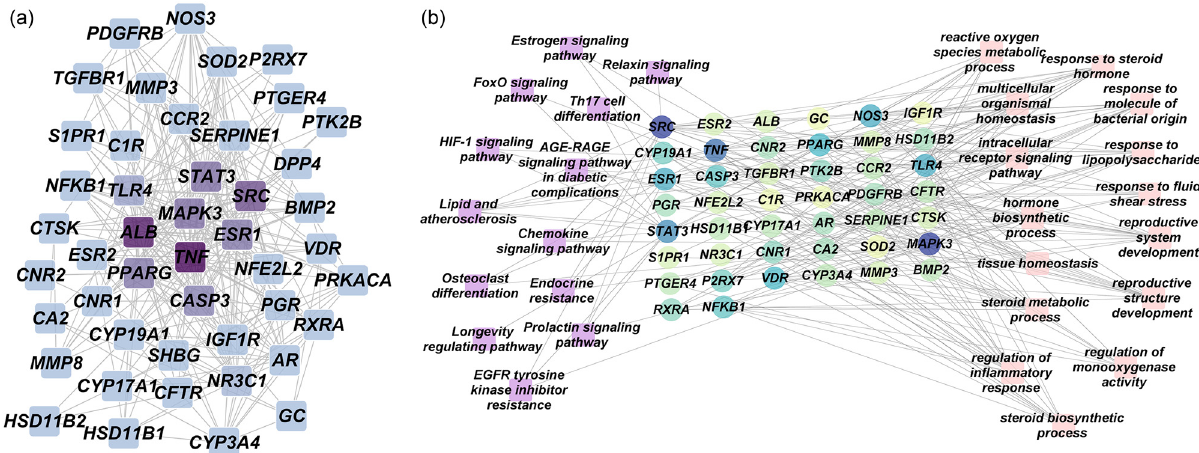
Figure 2: PPI and target - pathway networks for potential targets of β - ecdysone treating osteoporosis. ( a ) The PPI network constructed by proteins encoded by potential targets of β - ecdysone treating osteoporosis. The darker color represents higher degree of nodes. ( b ) The association between potential targets, top 15 GO BP terms, and top 15 KEGG pathways. Circles represent targets, purple quadrates represent KEGG pathways, and pink quadrates represent GO BP terms.